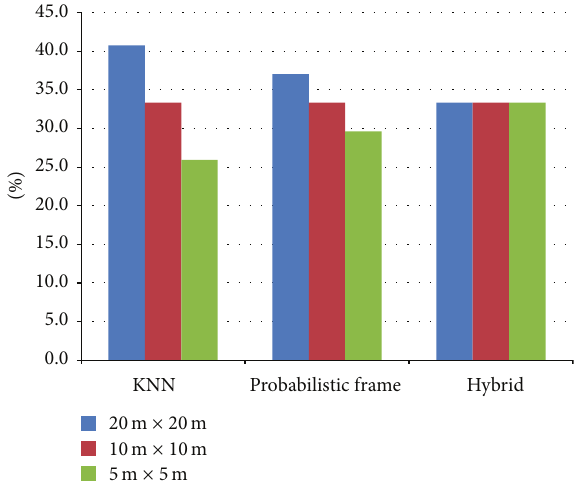
Figure 4: Performance comparison for grid segmentations.